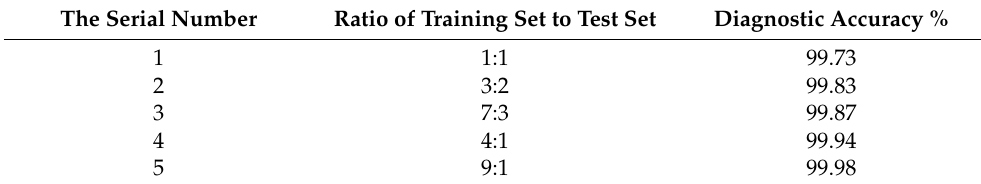
Table 7. Comparison results of different scales of dividing the